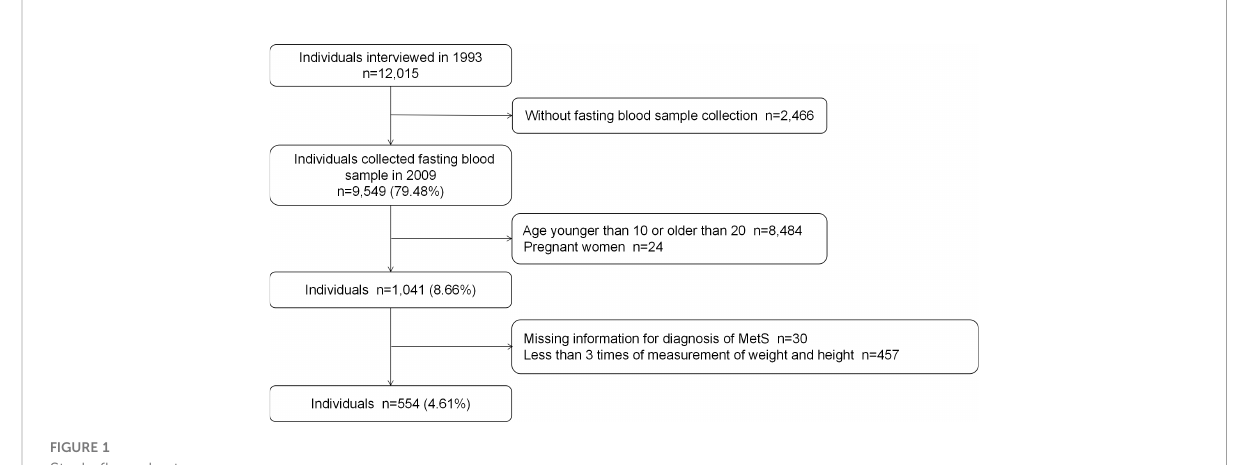
FIGURE 1 Study fl ow